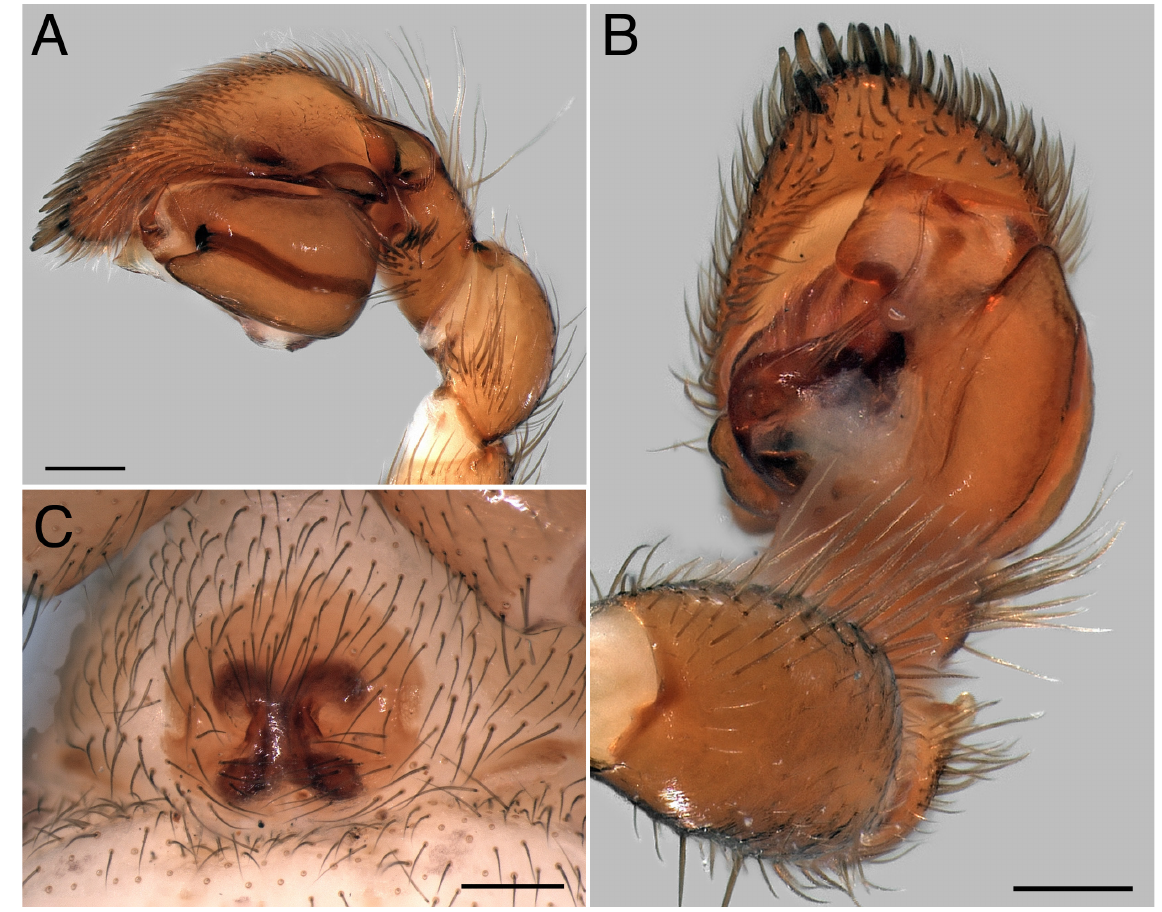
Fig. 13. Ballomma neethlingi gen. et sp. nov. A–B . Paratype, ♂ (NCA 76/1048) C . Holotype, ♀. A . Male palp, retrolateral view. B . As preceding, ventral view. C . epigyne, ventral view. Scale bars: 0.2